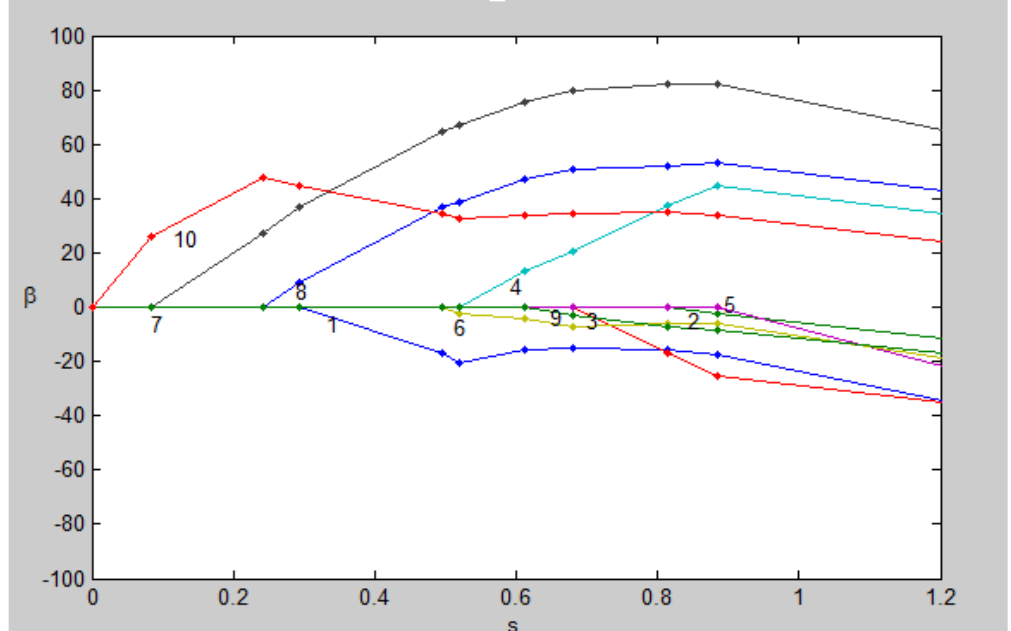
Figure 6. The selection process of fuzzy rules through LARS.